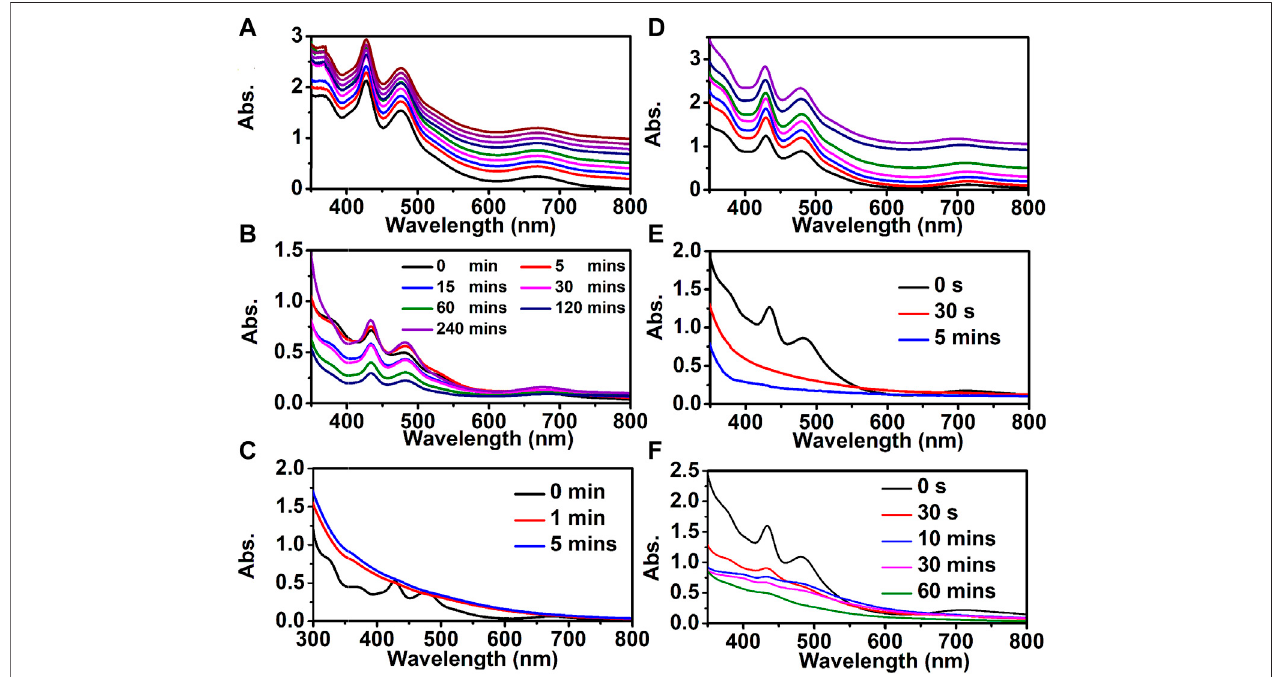
FIGURE6| Thestabilitytest: (A – C) for[Au 9 Ag 12 (SAdm) 4 (Dppm) 6 Cl 6 ](SbF 6 ) 3 and (D – F) for[Au 9 Ag 8 Cu 4 (SAdm) 4 (Dppm) 6 Cl 6 ](SbF 6 ) 3 nanocluster. (A,D) thethermal stability test; (B, E) oxidizing stability test; (C, F) reducing stability test.